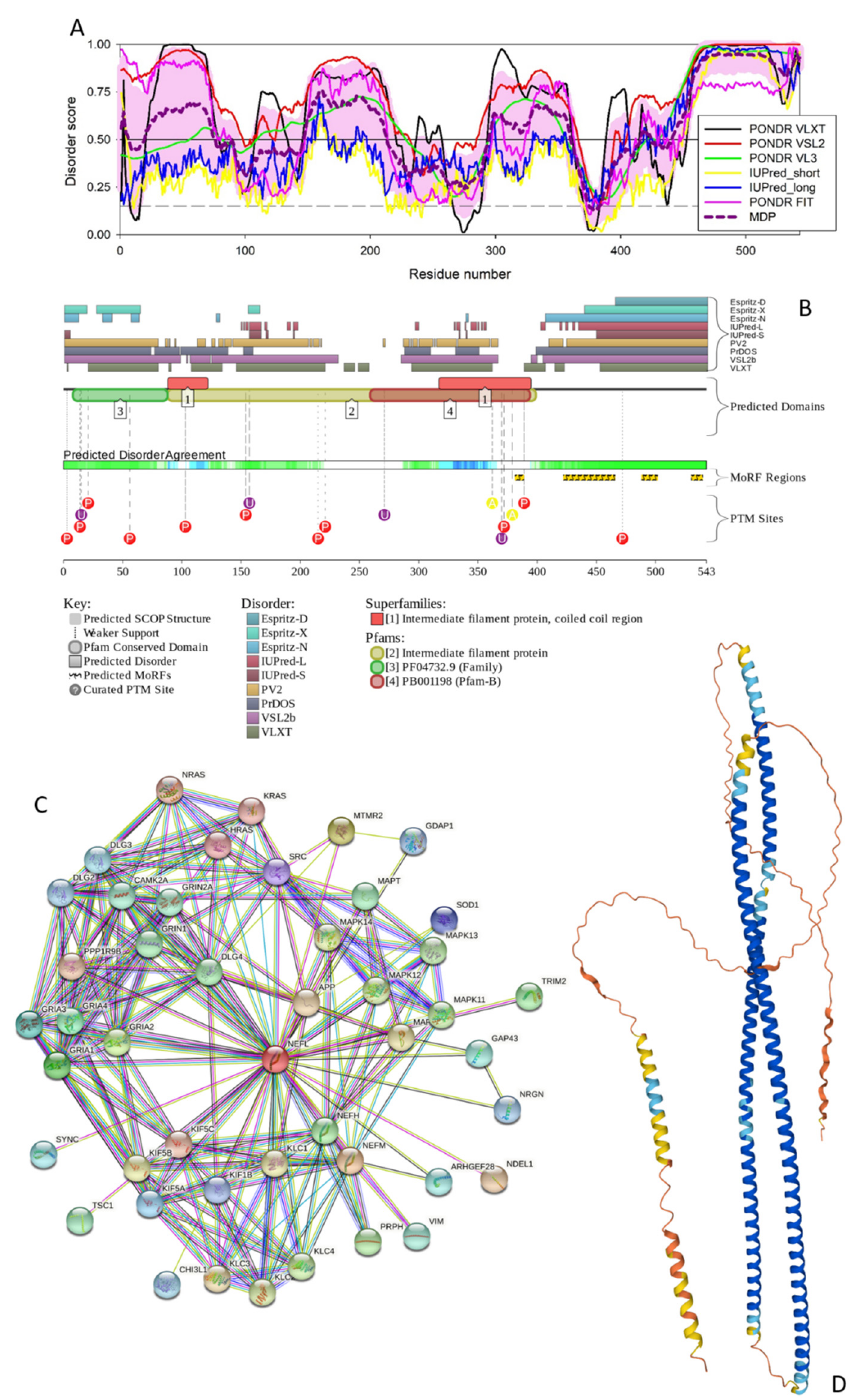
Figure 3. Functional disorder analysis of human NFL (UniProt IDs: P12036). ( A ) Per-residue disorder profile generated by RIDAO. ( B ) Functional disorder profile produced by the D2P2 platform. ( C ) STRING-generated PPI network centered at NFL. ( D ) 3D structure modeled for NFL by AlphaFold. Structure is colored based on the pLDDT values, where segments predicted with very high (pLDDT > 90), high (90 > pLDDT > 70), low (70 > pLDDT > 50), and very low (pLDDT < 50) confidence are shown by blue, cyan, yellow and orange colors, respectively.